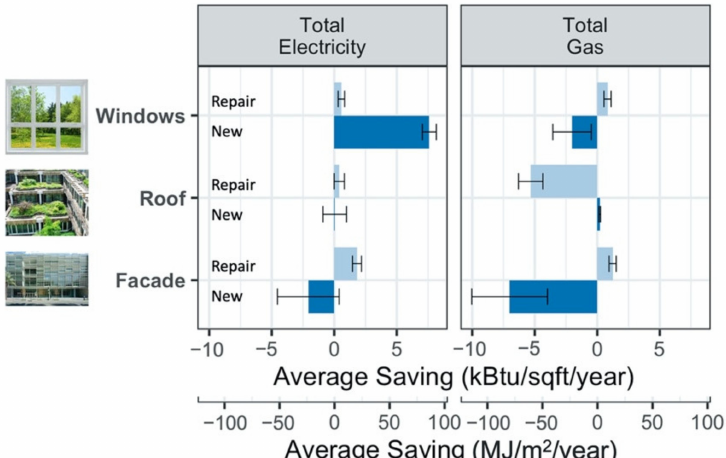
Figure 9. Bar chart of the mean and 95% C.I. of the estimated retrofit effects of past building envelope retrofit sub-actions on the site electricity EUI and site gas EUI.